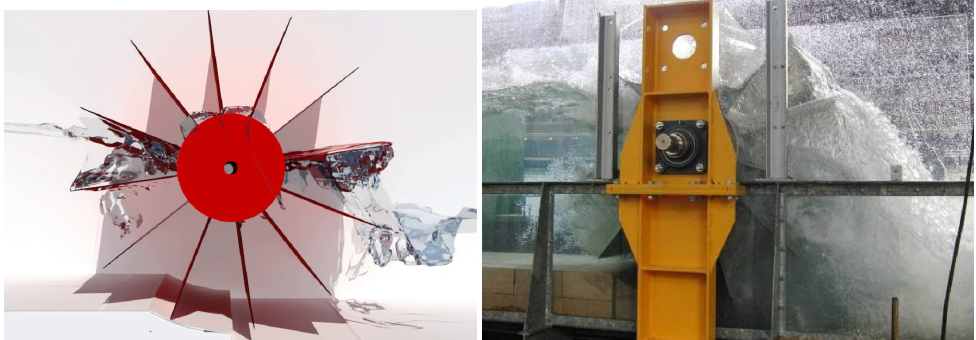
Figure 23. Lateral image of the instantaneous flow of water through the HPM for low discharge. Left image shows an instantant of simulations with caffa3d for Q = 120 L/s, while right image shows an instant of experimental tests for Q = 180 L/s with the level downstream of the wheel 200 mm below the edge of the hub